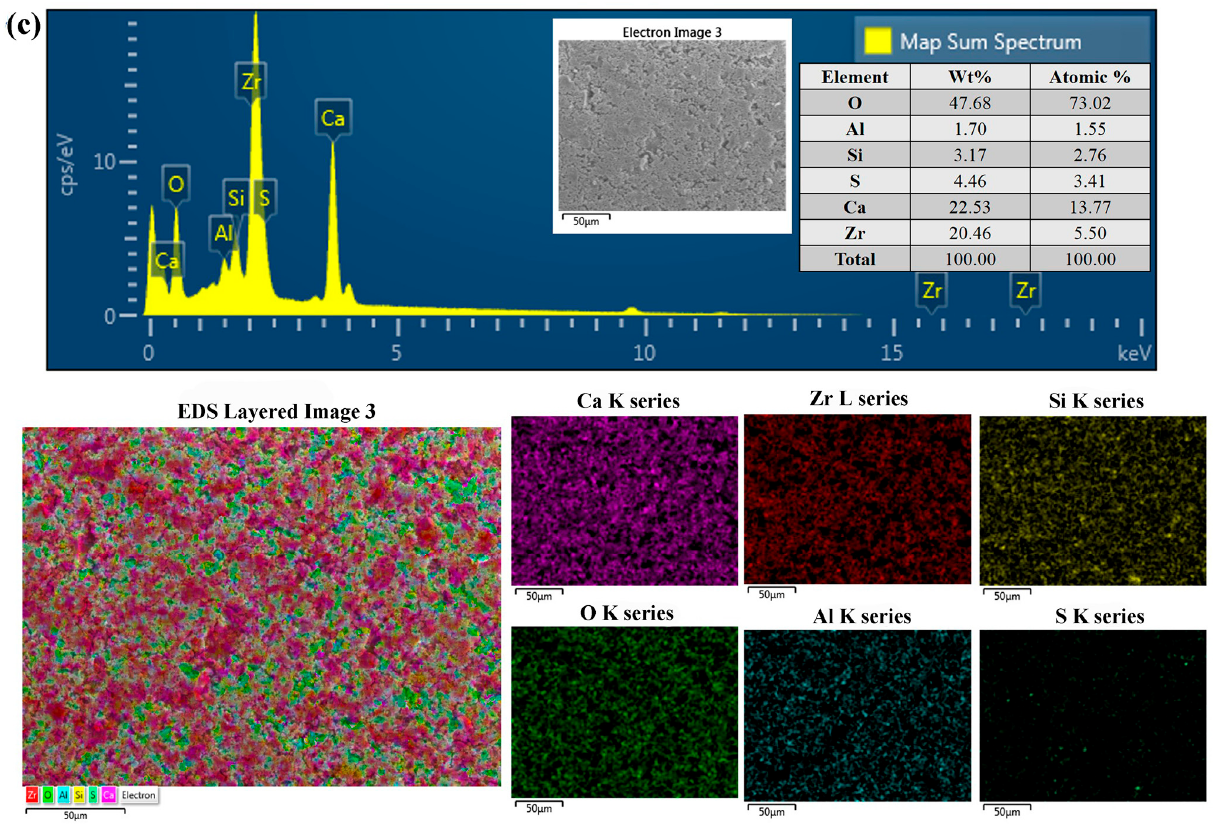
Figure 2. FE-SEM and EDX analysis of the experimental groups: ( a ) PZ, ( b ) PZF5, ( c ) PZF10. The surface morphology of PZ, PZF5, and PZF10 was studied under FE-SEM. The major components were analyzed and visualized with EDX. FES-SEM: field emission-scanning electron microscope; EDX: energy dispersive X-ray.